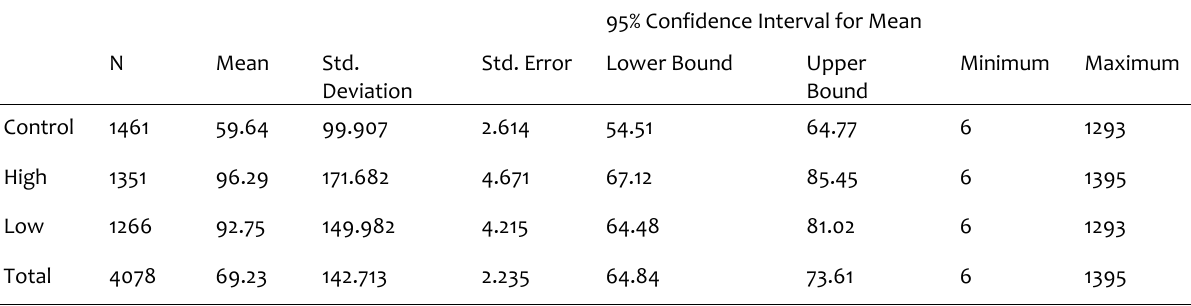
Table III. Descriptive statistics for the One-way ANOVA analysis for differences in foraging bout duration between test groups.